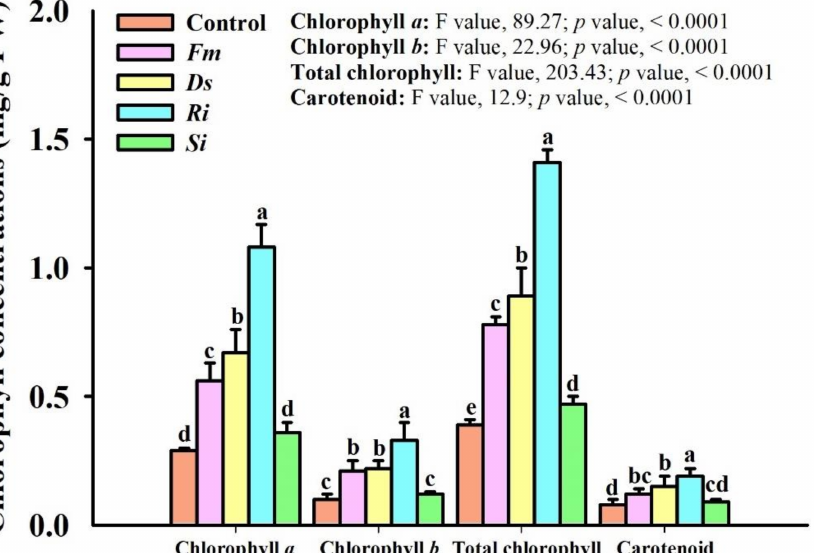
Figure 3. Effects of arbuscular mycorrhizal fungi and Serendipita indica on leaf chlorophyll fractions concentrations of Vicia villosa seedlings. Data (means ± SD, n = 4) followed by different letters above the bars indicate significant ( p < 0.05) differences. For abbreviations see Figure